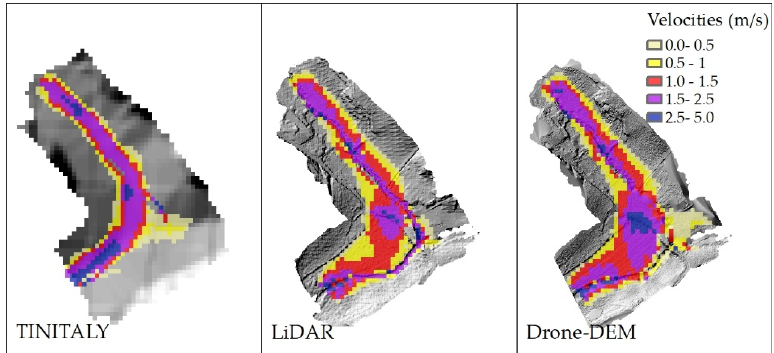
Figure 9. Maximum asynchronous flow velocities of the simulations from TINITALY, LiDAR, and Drone-derived DEMs (200 years return period). Table 4. Values of Mean Deviation (MD), Root Mean Square Deviation (RMSD), Standard Deviation (STD) of the maximum flow depths distributions of the simulations related to the TINITALY and Drone-DEM computational domains with respect to the ones of LiDAR-derived computational domain for the selected return periods (10, 50, 100, 200 years).